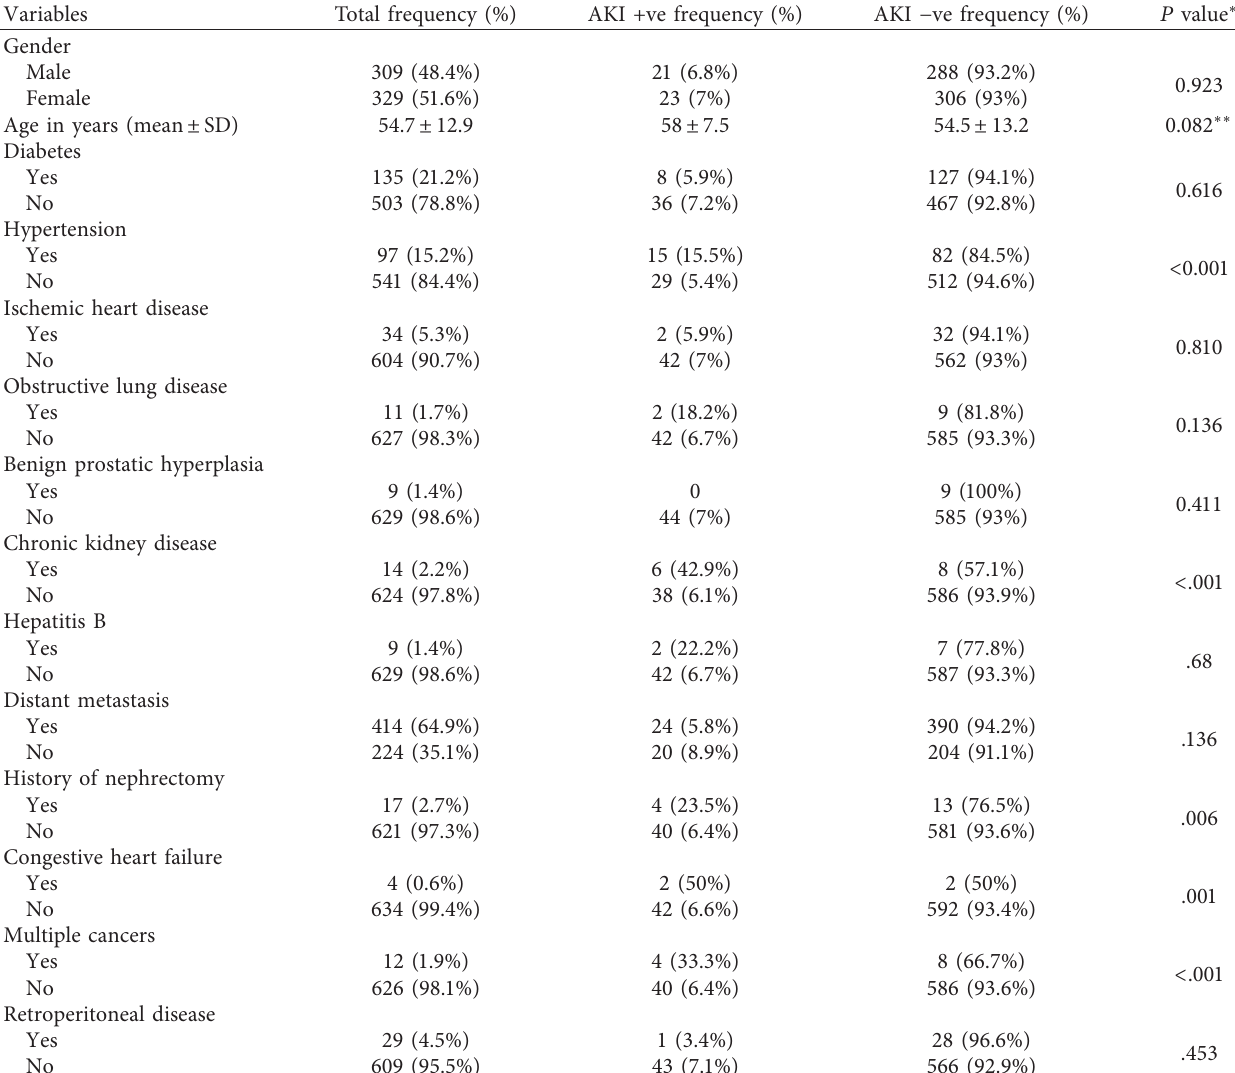
Table 1: Univariable analysis of AKI with cancer patients’ background characteristics and